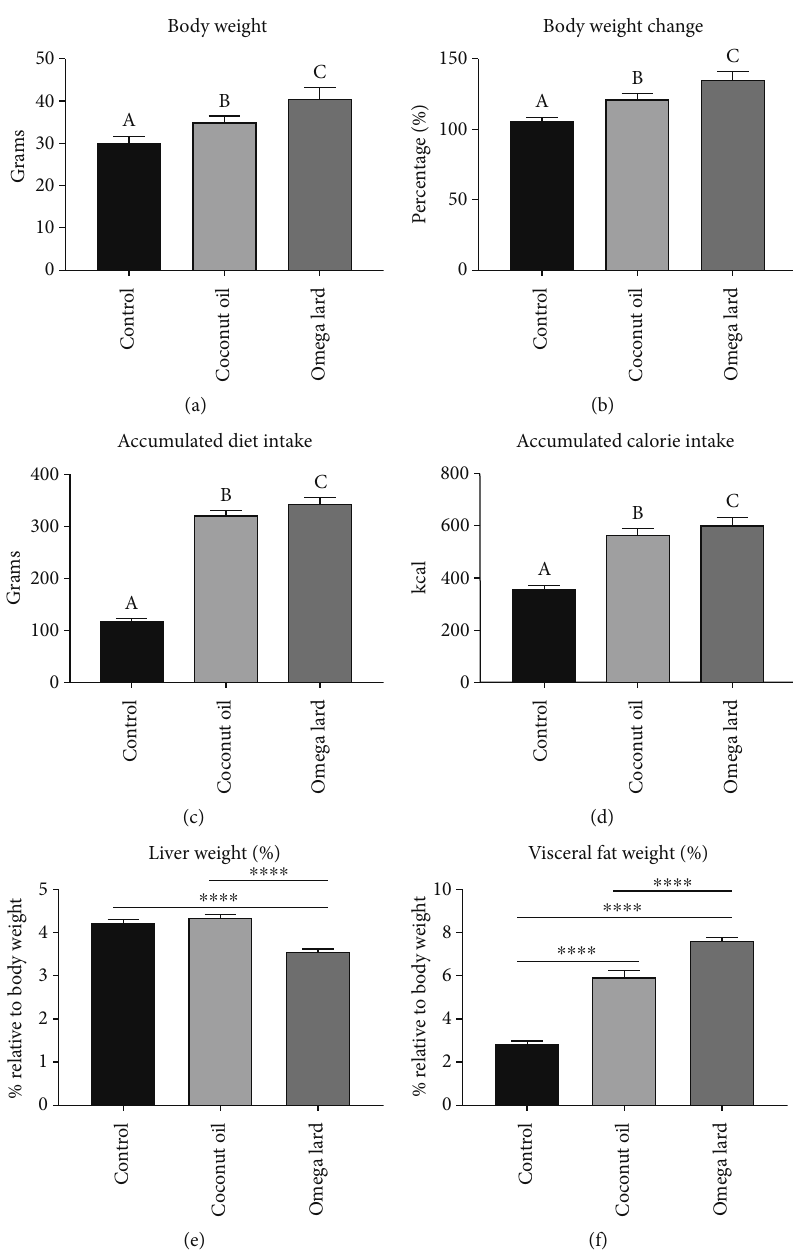
Figure 1: Di ff erences in body weight, dietary intake, and organ weight. The di ff erences in body weight (a), change in body weight (b), accumulated dietary intake(c), accumulated calorie intake (d), relative liver weight (e), and relative visceral fat weight (f) of all groups are shown. Control, coconut oil, and omega lard refer to the control, coconut oil-fed, and omega lard-fed groups, respectively. Body weight and change in body weight were estimated at the end of the experiment (four weeks). The accumulated dietary and calorie intakes were estimated daily. Liver and visceral fat tissues were harvested at the end of the experiment, and their weights were measured relative to the body weight of the mice. The number of mice was 8, 7, and 8 in the control, coconut oil-fed, and omega lard-fed groups, respectively. Data are presented as mean ± SEM . Uppercase letters and asterisk indicate signi fi cant di ff erences between groups ( P < 0 : 05